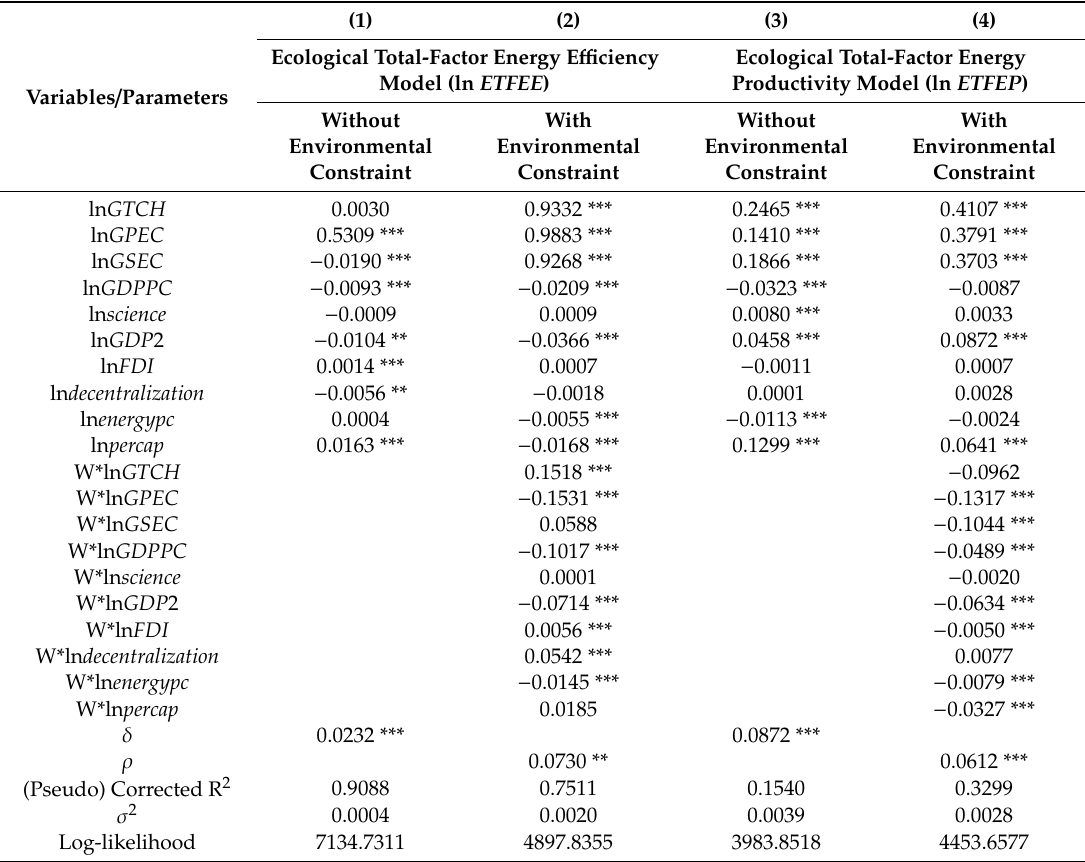
Table 4. Estimation results of spatial panel data